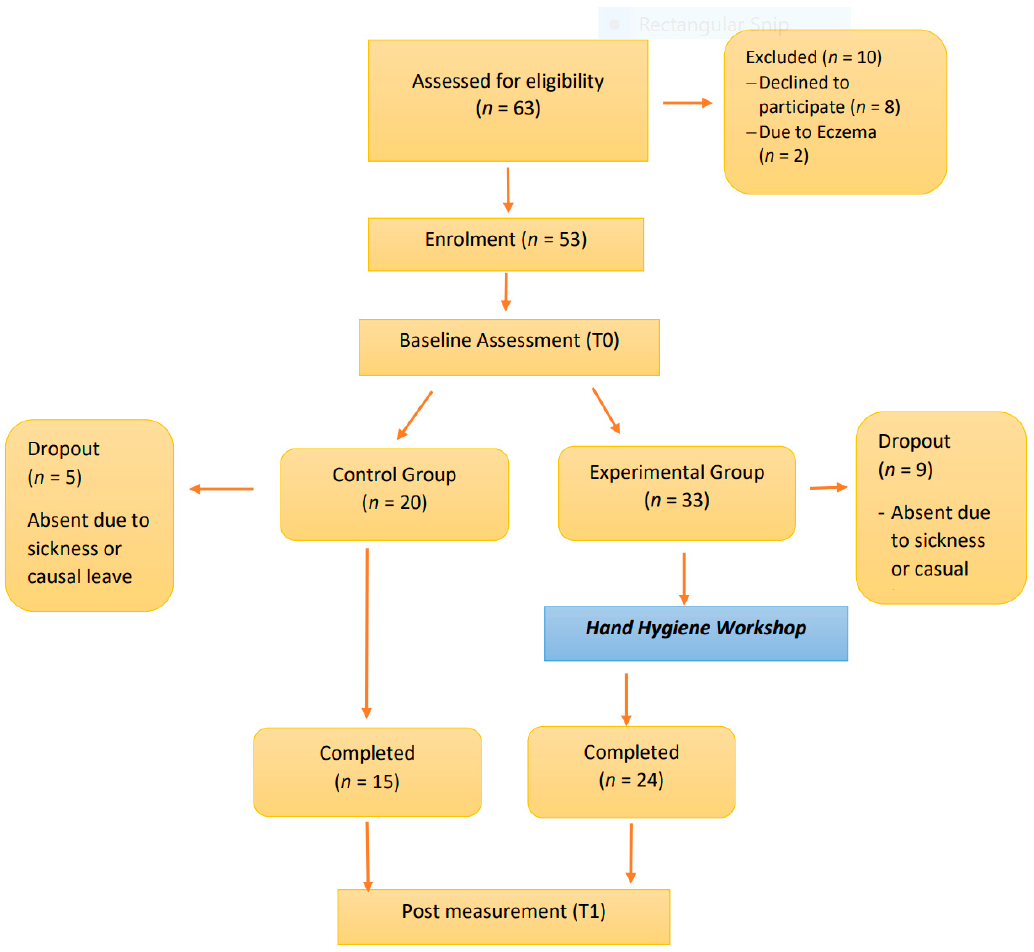
Figure 7. Flowchart of study.